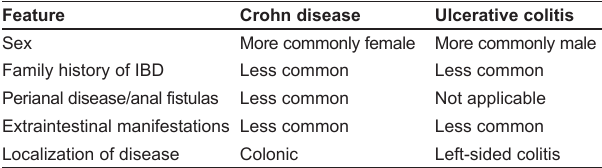
Table 4 Summary of clinical features of inflammatory bowel disease (IbD) in elderly patients Feature